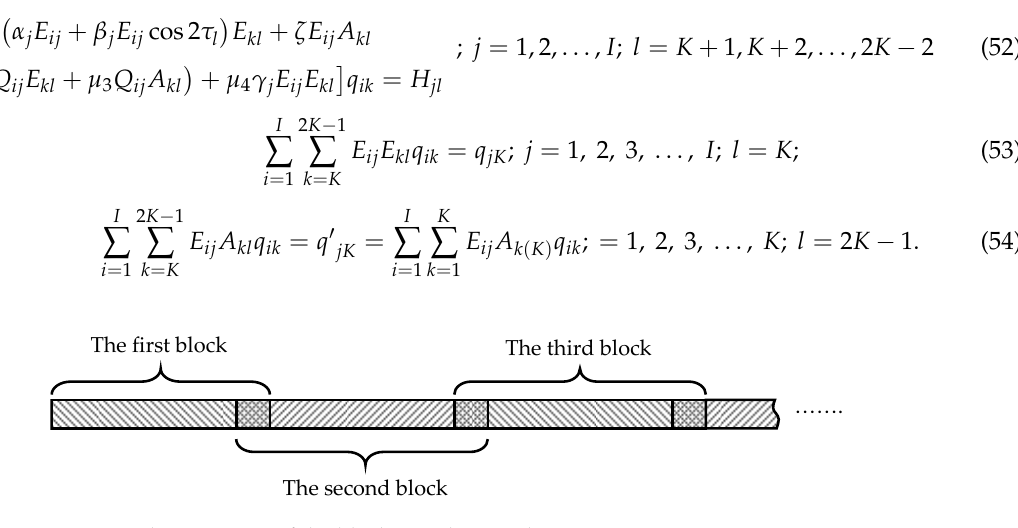
Figure 3. the sequence of the block-marching technique. Figure 3. The sequence of the block-marching